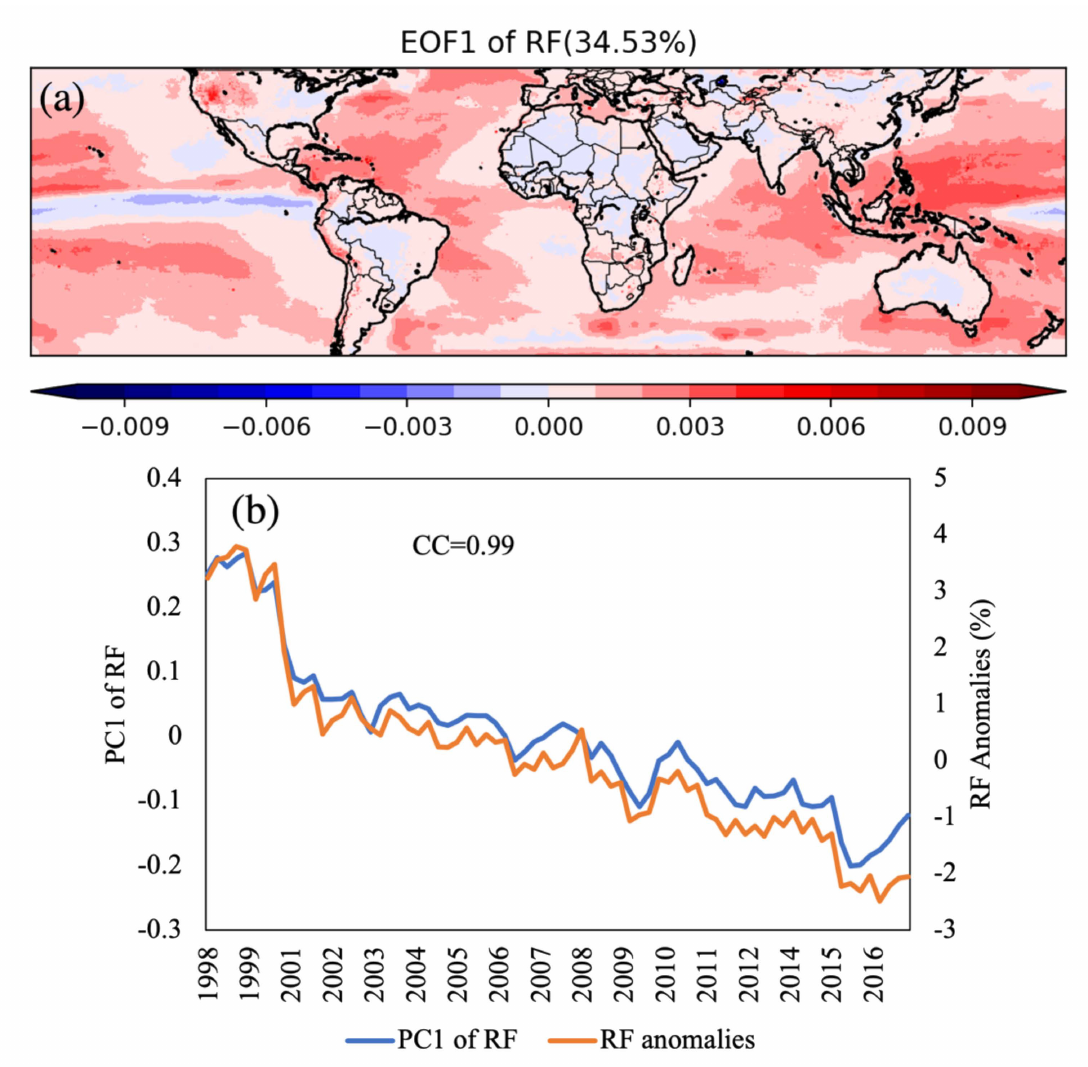
Figure 9. The same as Figure 8 but for RF. The variance explained is 34.53%. ( a ) The first EOF pattern and ( b ) its associated time series of